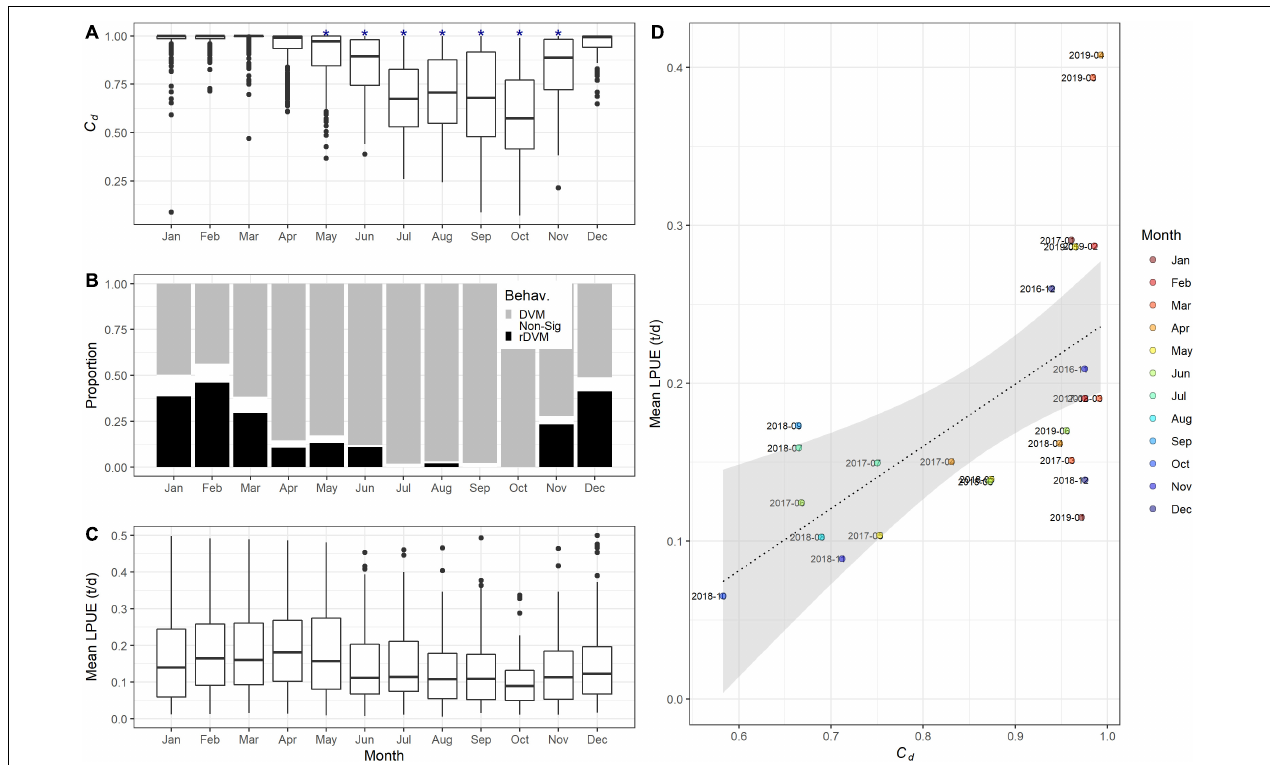
FIGURE 5 | (A) Monthly proportion of time that tagged yellowfin tuna spent utilising depths shallower than 100 m ( C d ). Significantly lower C d compared to other months denoted with asterisk ( P < 0.05). (B) Monthly proportion of time spent in each vertical movement behaviour [diel vertical migrations (DVM), when there was no significant difference in depth use between night and day (Non-Sig) and reverse DVM (rDVM)]. (C) Monthly mean landings per vessel per day (LPUE) for the yellowfin tuna fishing fleet of St Helena. (D) Correlation between C d and mean total landings per month with linear